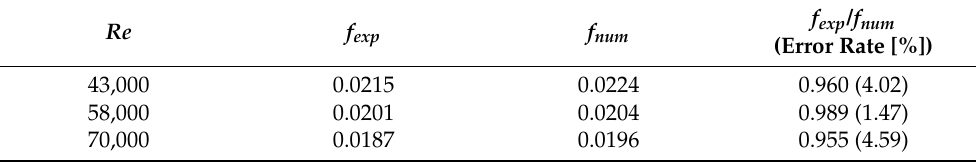
Figure 5 . The experimental appartus .